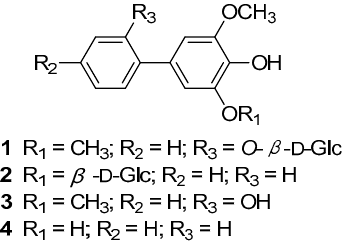
Figure 5. Biphenyl and biphenyl glycosides isolated from YE-treated S. pohuashanensis suspension cells.